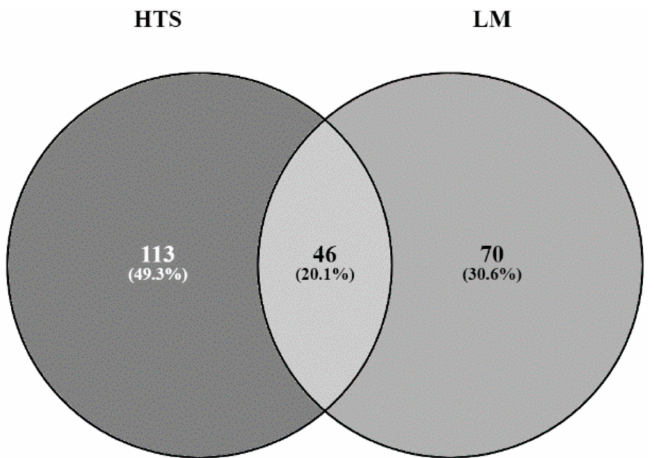
Figure 2. Venn diagram comparing similarities and differences between inventories obtained by microscopy (LM, light grey circle) and metabarcoding (HTS, dark grey circle) analysis. (Absolute number are number of